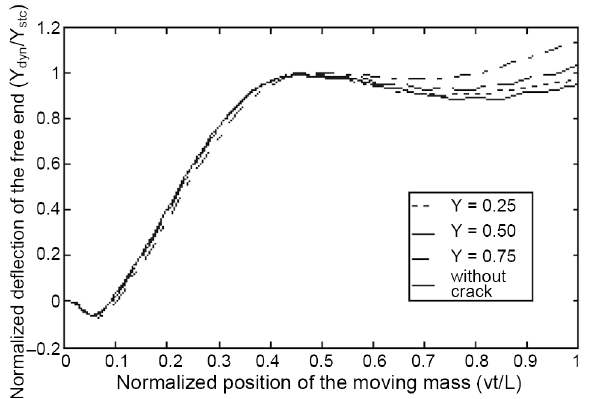
Fig. 2. Variation of the normalized deflection at the free end with respect to normalized position of moving mass for various values of crack depth ratio (γ). L 0 = 4 m, v = 10 m/s,